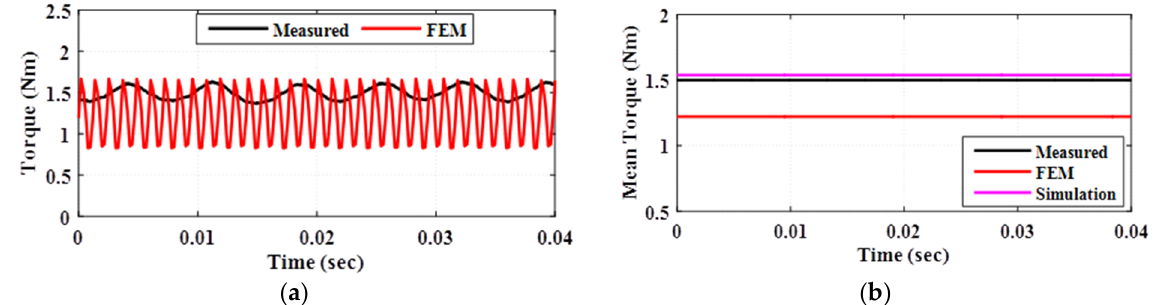
Figure 15. Comparison between measured and FE-predicted torque as a generator: ( a ) torque waveform; ( b ) average torque. Table 3. Summary of torque results.